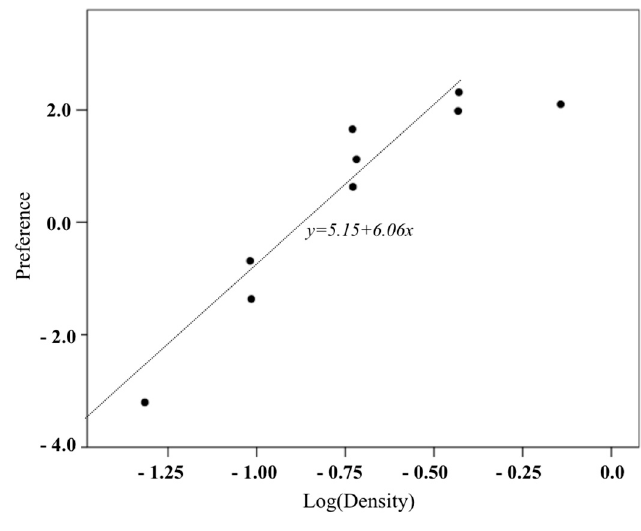
Figure 4. Scatter plot between preference and cookie box density.